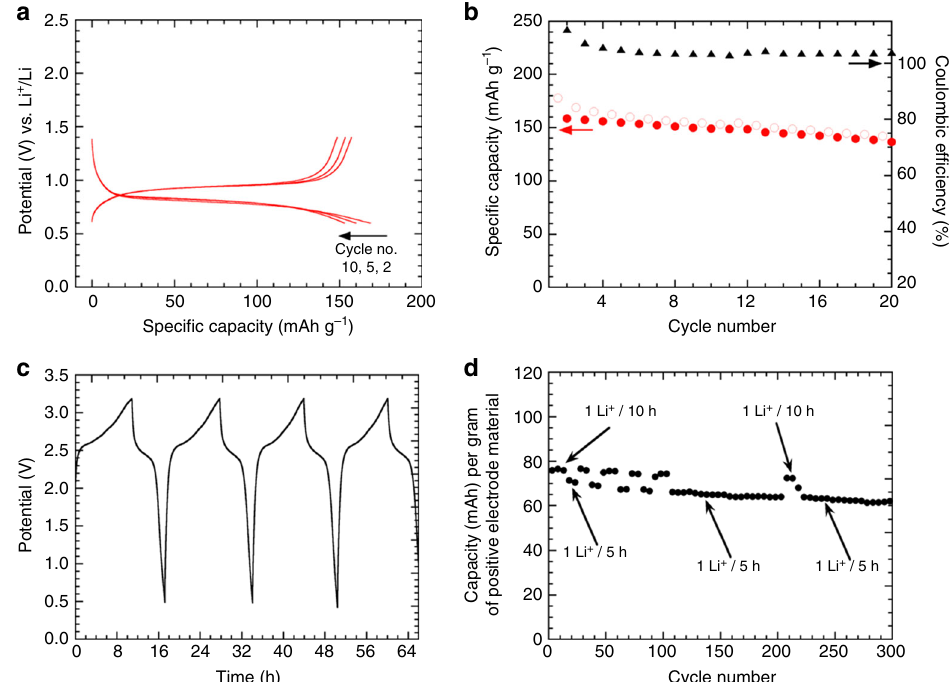
Fig. 7 All-organic symmetric Li-ion cell based on Mg(Li 2 )- p -DHT. a Potential vs. speci fi c capacity curve (cycle nos. 2, 5 and 10) of a Li half-cell using Mg (Li 2 )- p -DHT as the active electrode material, mixed with 33 wt.% GM15 (no binder) and galvanostatically cycled at a rate of 1 Li + /5 h ( I = 11.5 mA g − 1 ) in the 0.6 – 1.4 V potential range using LiPF 6 1 M in EC/DMC as the electrolyte. b Corresponding capacity retention curve. c Charge – discharge pro fi le of the symmetric Li-ion cell made of Mg(Li 2 )- p -DHT with a ratio of 1:1 showing an output voltage of 2.5 V ( I = 11.5 mA g − 1 based on the weight of Mg(Li 2 )- p -DHT contained in the positive electrode). d Speci fi c capacity vs. cycle number for current rate changes ranging from 1 Li + /10 h to 1 Li + /5